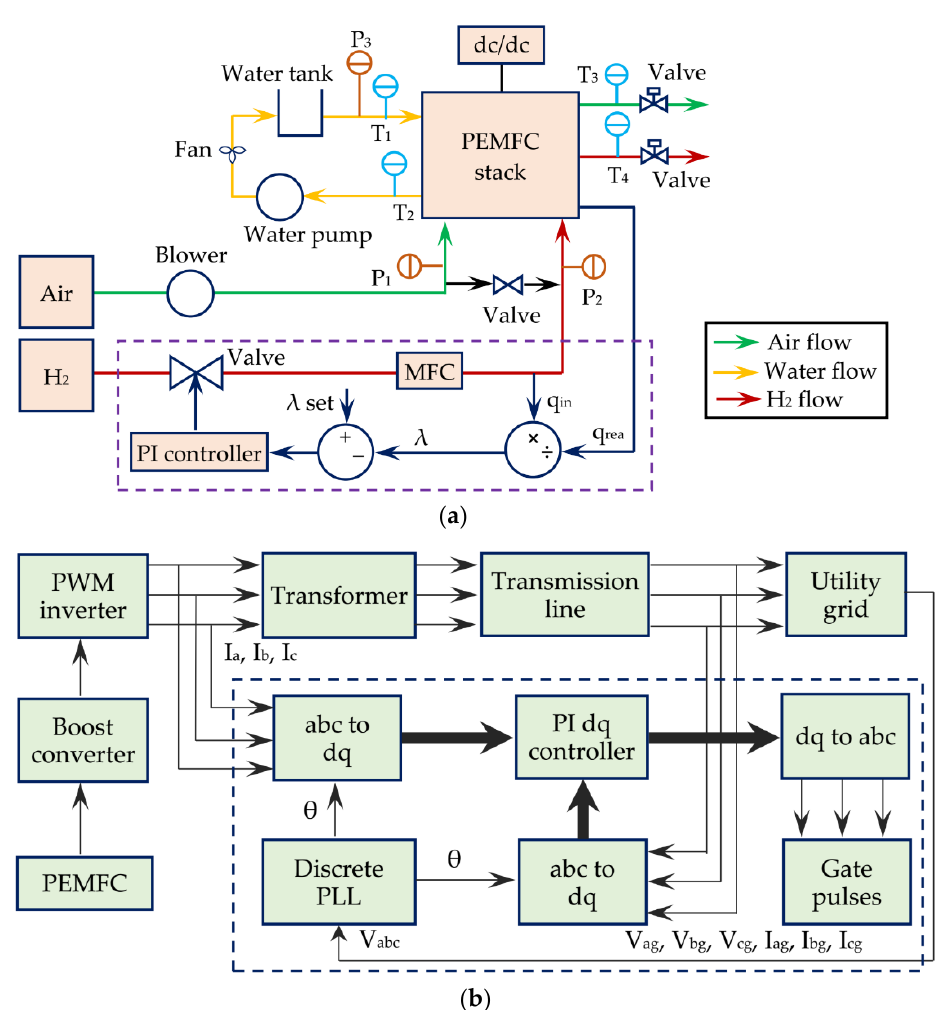
Figure 5. ( a ) PEMFC scheme and ( b ) blocks for connection to the grid. Reproduced from [19] under the Creative Commons Licence.